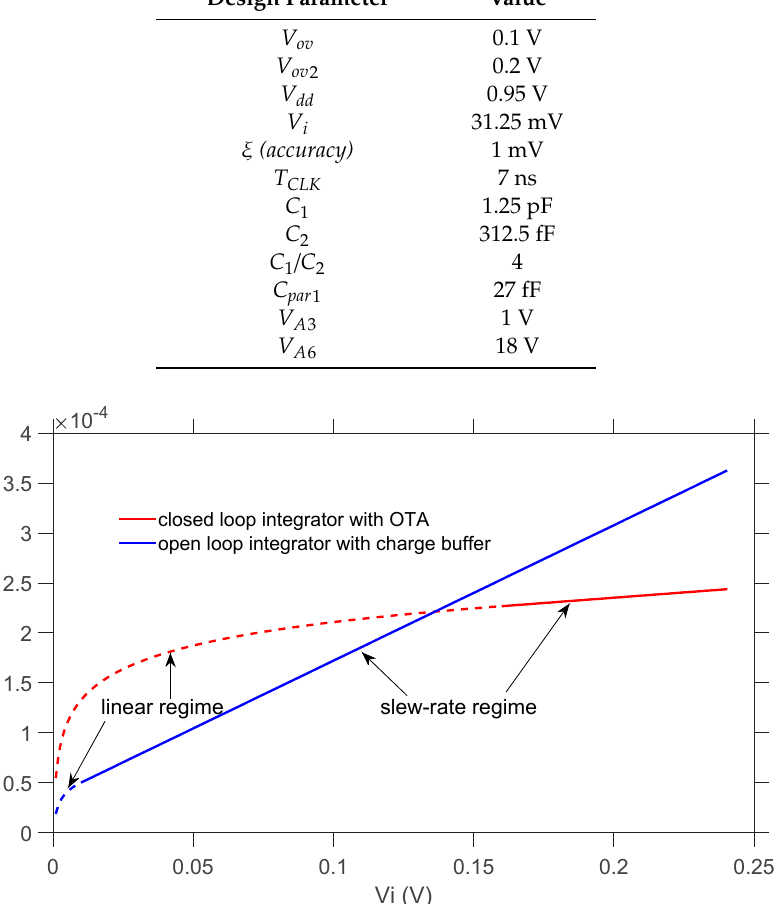
Figure 10. Minimum power consumption for the closed and the open-loop switched-capacitor integrators.